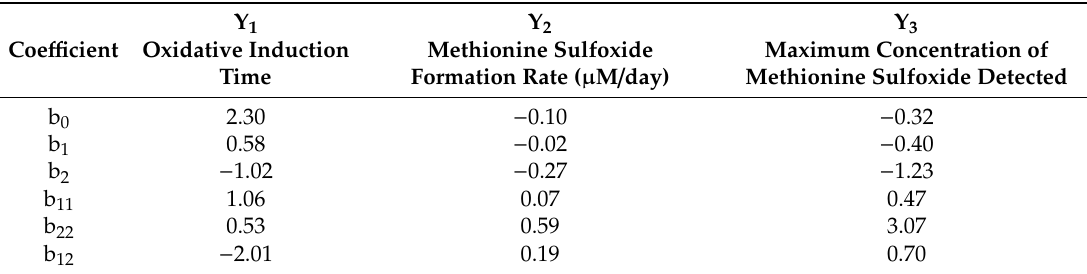
Table 3. Coe ffi cients obtained from experimental